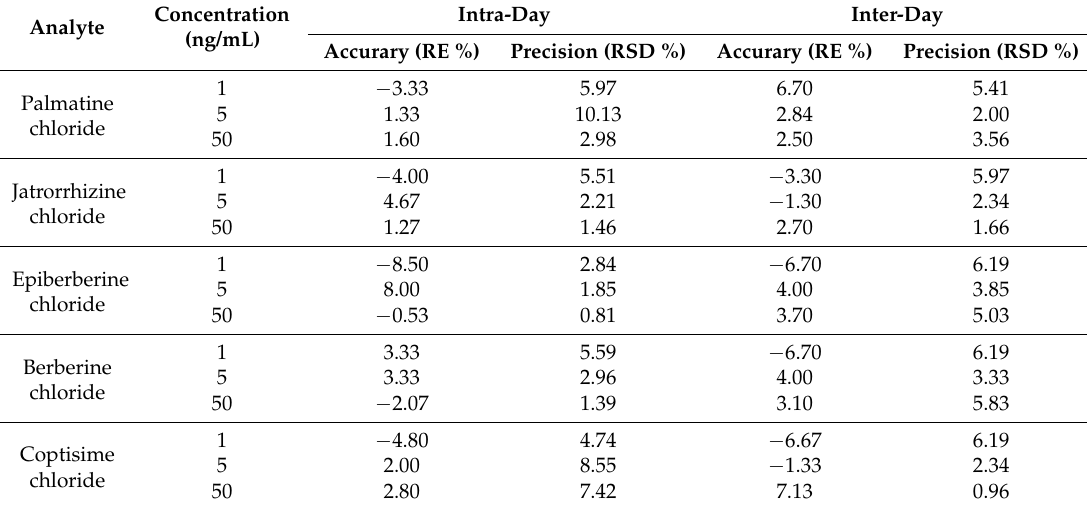
Table 3. Accuracy and precision for the five alkaloids in plasma ( n = 6); RE: relative error; RSD: relative standard deviation.